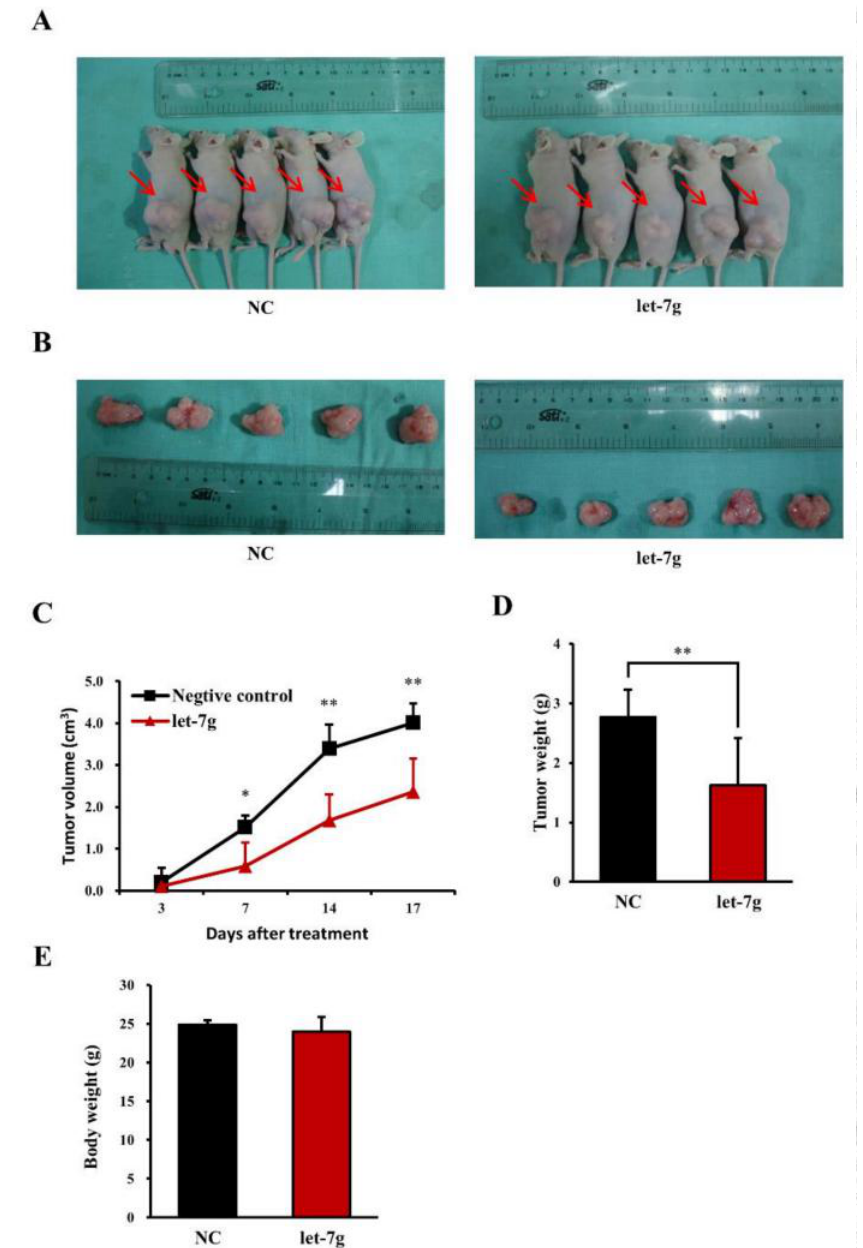
Figure 6. Effect of let-7g on colorectal cancer cell growth in nude mice. ( A ) Nude mice orthotopically transplanted with Caco-2 cells were treated with interval injections of a liposome-entrapped miRNA negative control and let-7g . The orthotopic tumor size was imaged. ( B ) Orthotopic tumor tissues of nude mice were surgically removed and imaged. ( C ) Orthotopic tumor sizes were measured at 3, 7, 14 and 17 days after tumor implantation. ( D ) The tumor weight of surgically removed tumor tissues were measured. ( E ) The body weights of nude mice were measured. **, statistically significant at a p -value of